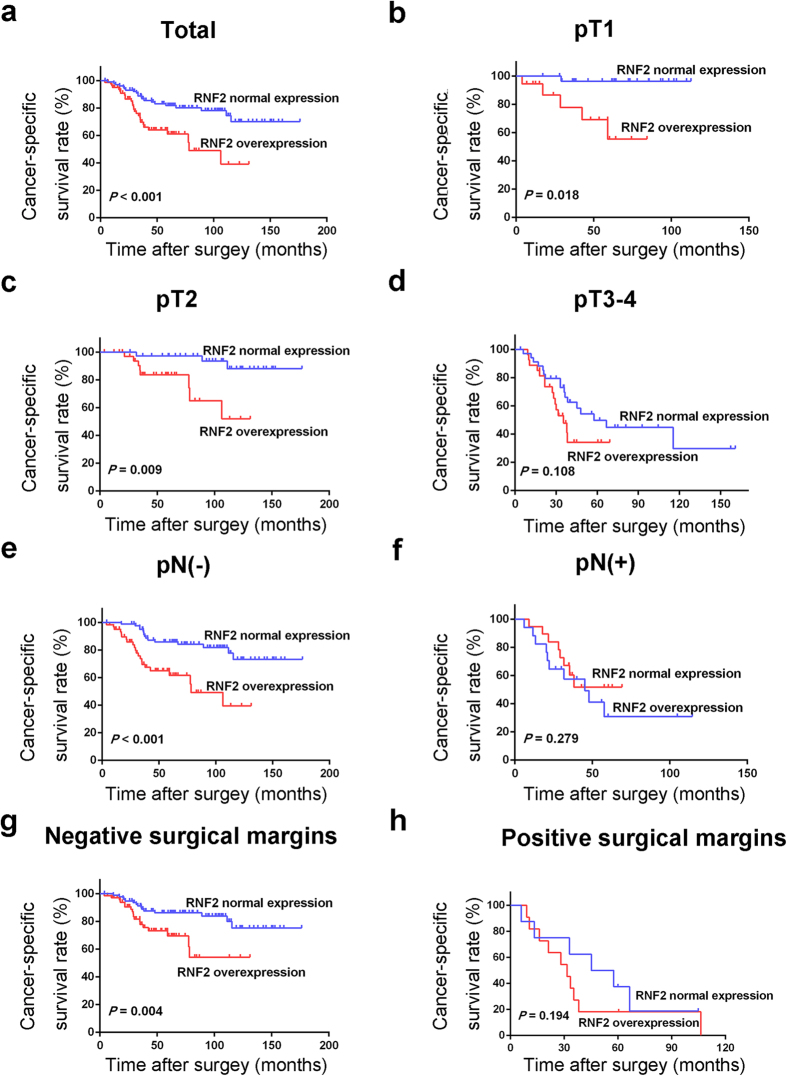
Cancer-specific survival analysis of RNF2 expression in total cohort and different subsets of UCB patients.(a) Total cohort; (b) pT1; (c) pT2; (d) pT3/4; (e) pN(−); (f) pN(+); (g) Negative surgical margins; (h) Positive surgical margins.